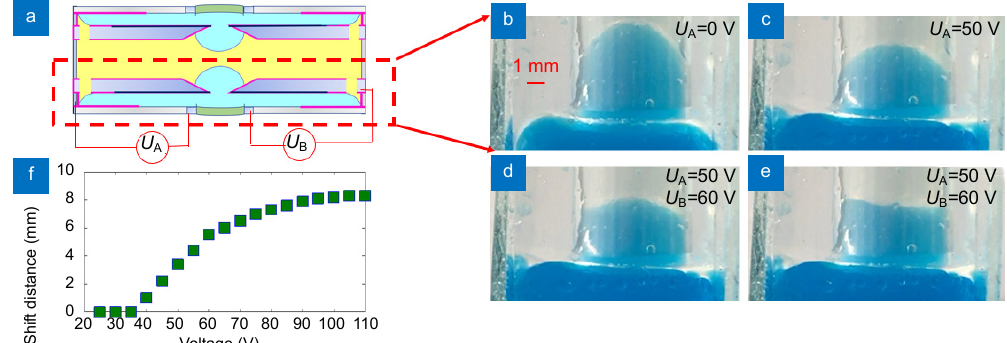
Fig. 2 | Performance of moving and deforming actuation of the movable electrowetting optofluidic lens. ( a ) Cell structure. ( b ) State 1, U A = 0 V, U B =0 V. ( c ) State 2, U A =50 V, U B =0 V. ( d ) State 3, U A =50 V, U B =60 V, t =0 s. ( e ) State 3, U A =50 V, U B =60 V, t =1 s. ( f ) Shift distance with differ- ent voltages.